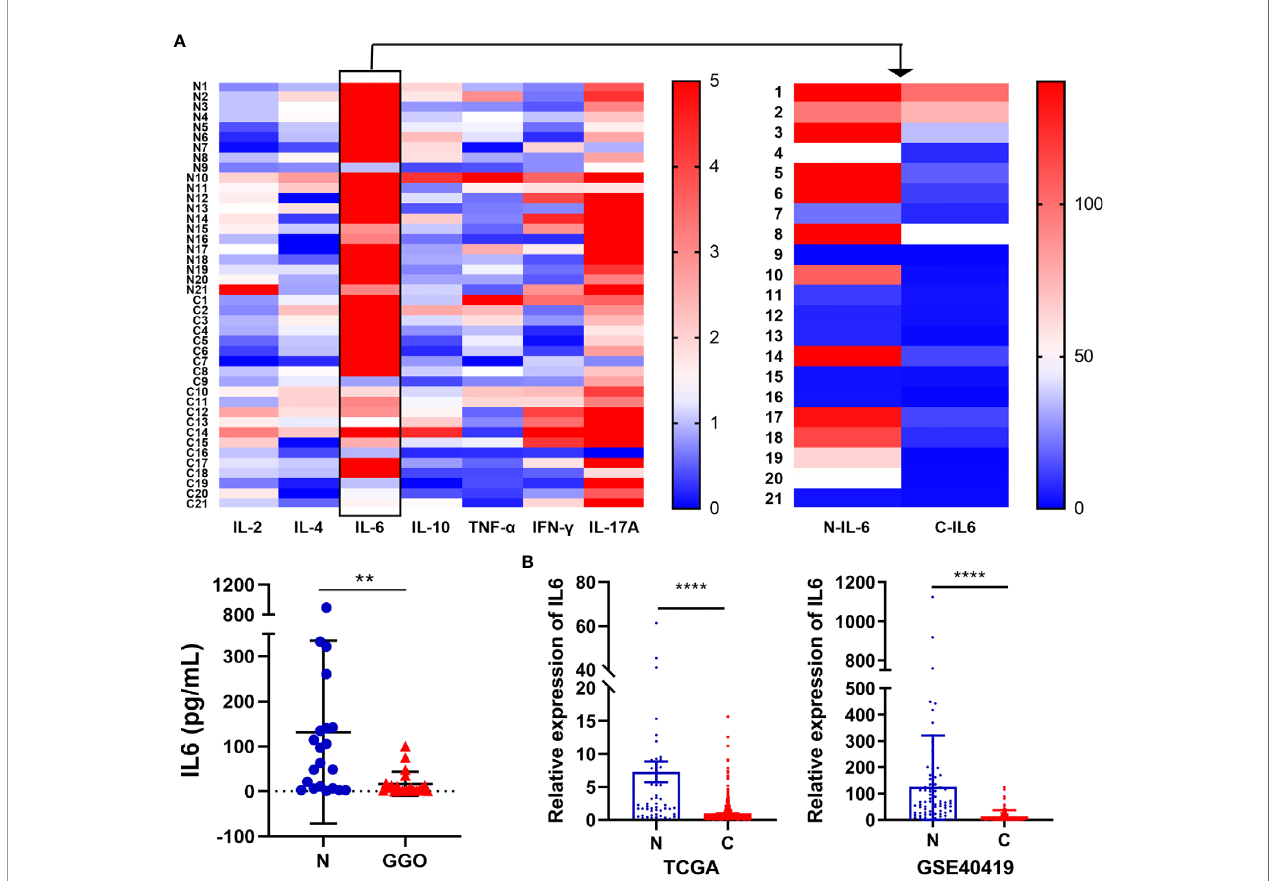
FIGURE 2 | The decrease of IL-6 in lung adenocarcinoma with GGO. (A) The fl ow cytometry result of several cytokines. The heatmap shows the expression status of 7 cytokines in 21 GGO patients (upper), while the scatter plot shows the expression of IL-6 (lower). (B) The mRNA level of IL-6 in TCGA (left, 59 normal and 535 cancer) and GEO (GSE40419) database (right, 77 normal and 87 cancer). Each dot represents an individual patient. Results are expressed as mean ± SEM. **P < 0.01; ****P < 0.0001. N, normal; C, cancer. .